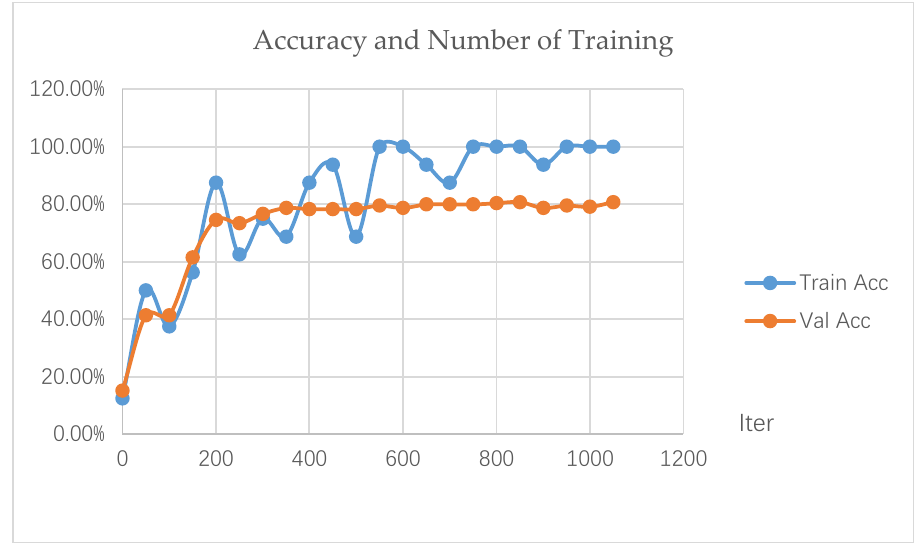
Figure 7. Loss rate and number of trainings.